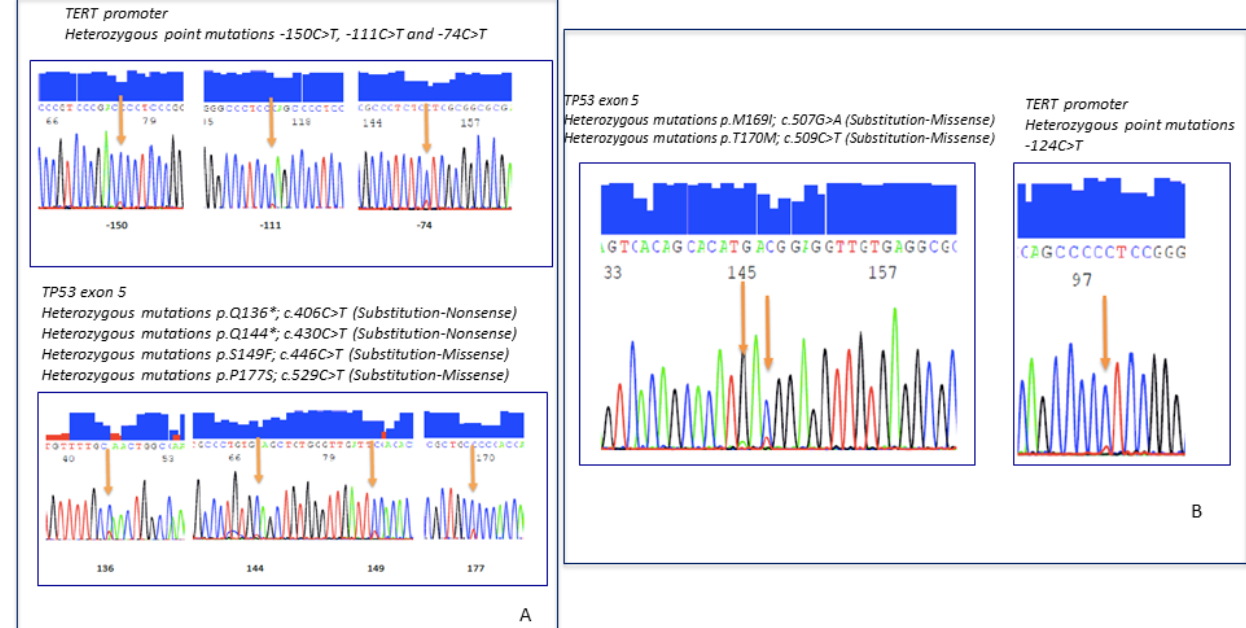
Figure 4. ( A ) Molecular analysis in high-risk SFT shows TP53 and TERT promoter mutations. ( B ) Dedifferentiated SFT with TP53 and TERT promoter mutations.